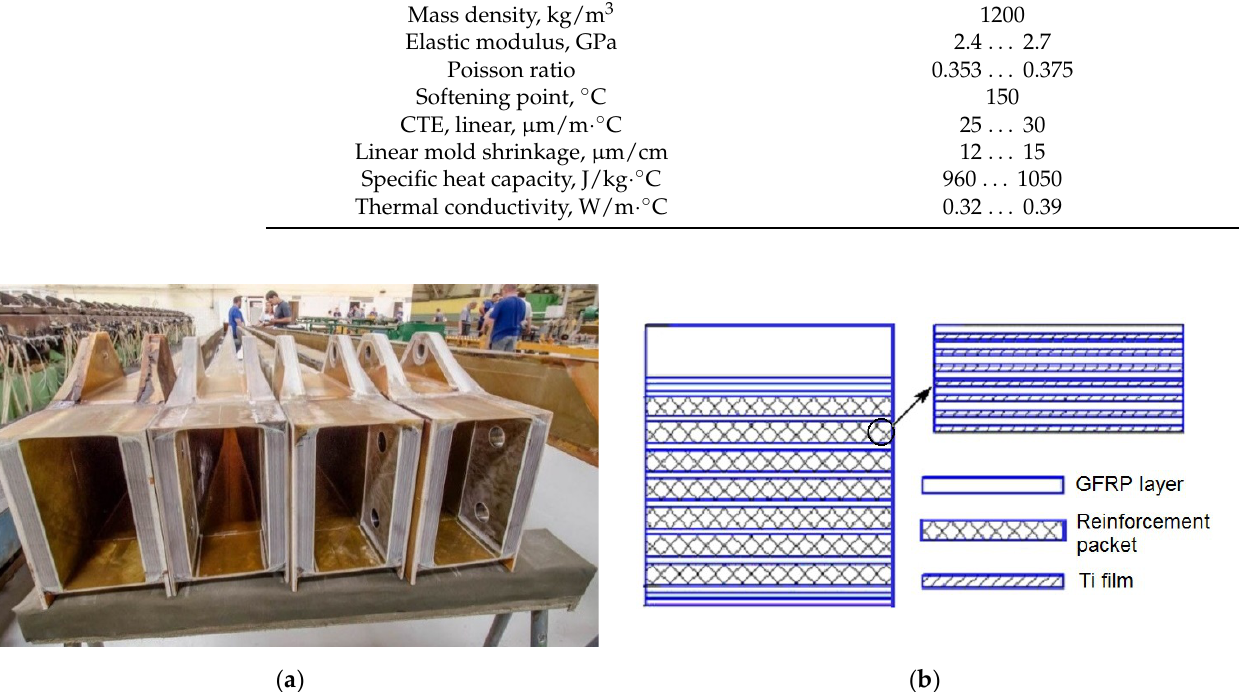
Figure 1. View of the root part of the spar before and after drilling the mounting holes ( a ); ( b ) layered structure of the drilled wall. Table 1. Physical and mechanical properties of E-glass fiber. Table 3. Mechanical properties of cross-ply GFRP laminate in the reinforcement